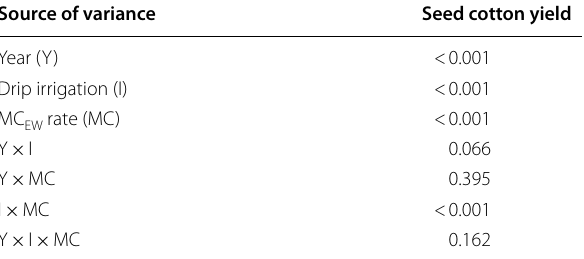
MC EW represents a 25% mepiquat chloride emulsion in water